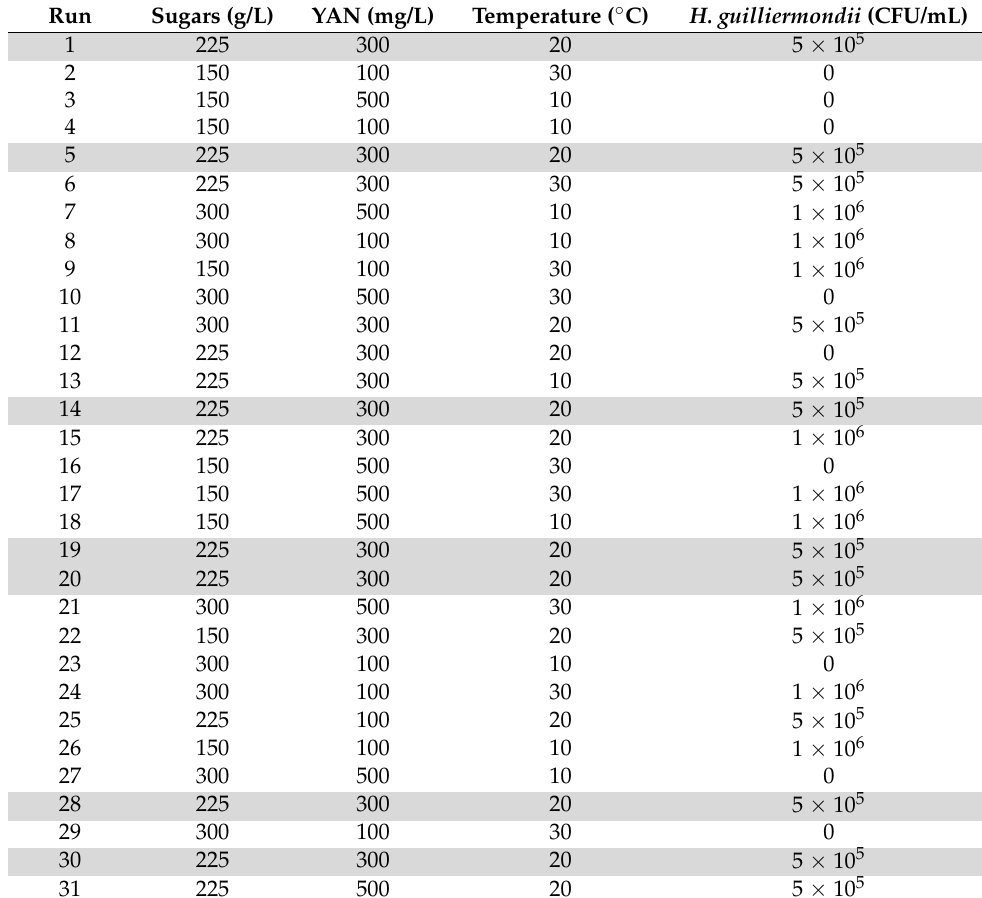
Table 2. Experimental conditions used following the CCD experimental plan. Shaded lines represent the seven replicates at the center of the experimental